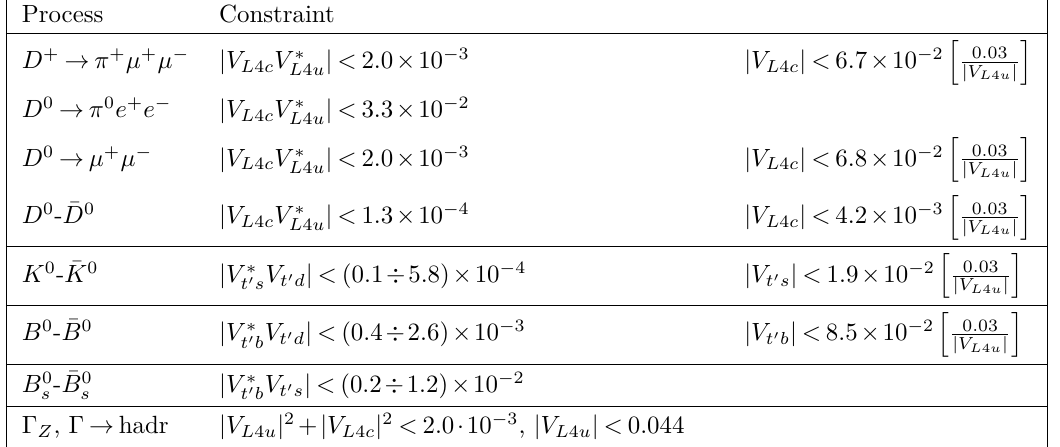
Table 7 . Limits on the mixing of the SM three families with a vector-like up-type isosinglet t 0 . The upper bounds obtained from neutral mesons mixing depend on the relative phases of the mixing elements and on the extra quark mass. Here the limits are computed for M t 0 = 1 TeV (see the text for details). Regarding the elements of CKM matrix, V t 0 d ≈ − V L 4 u , V t 0 s ≈ − V L 4 u V us − V L 4 c V cs − V L 4 t V ts and V t 0 b ≈ − V L 4 t , as in eq. (4.18).